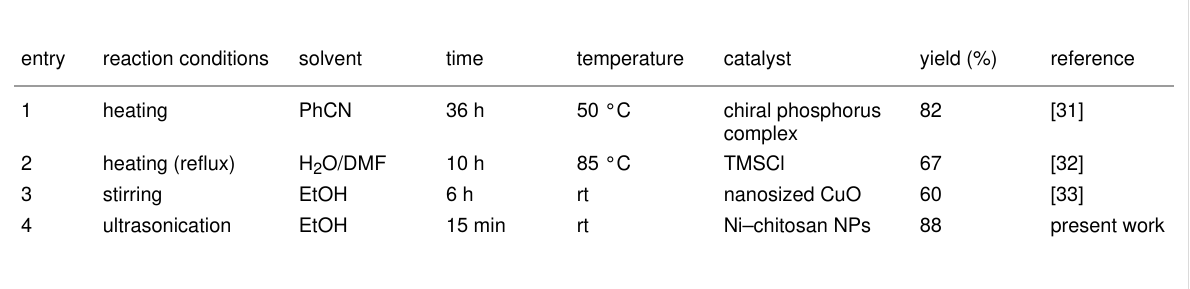
Table 3: Comparison between the previous reports on the synthesis of C5–C6-unsubstituted 1,4-DHPs and the present work.